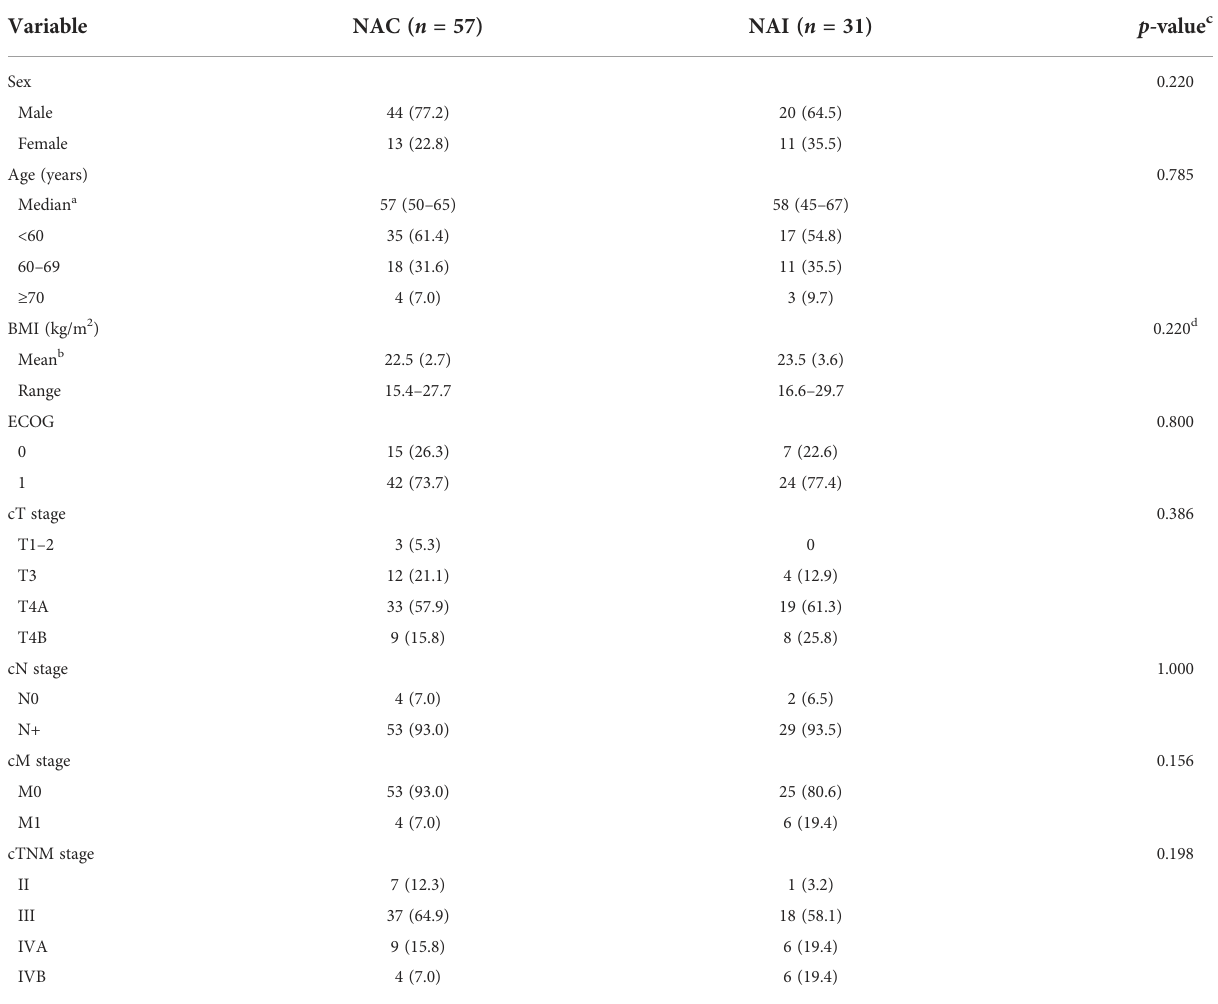
TABLE 1 Clinical data characteristics of intention-to-treat